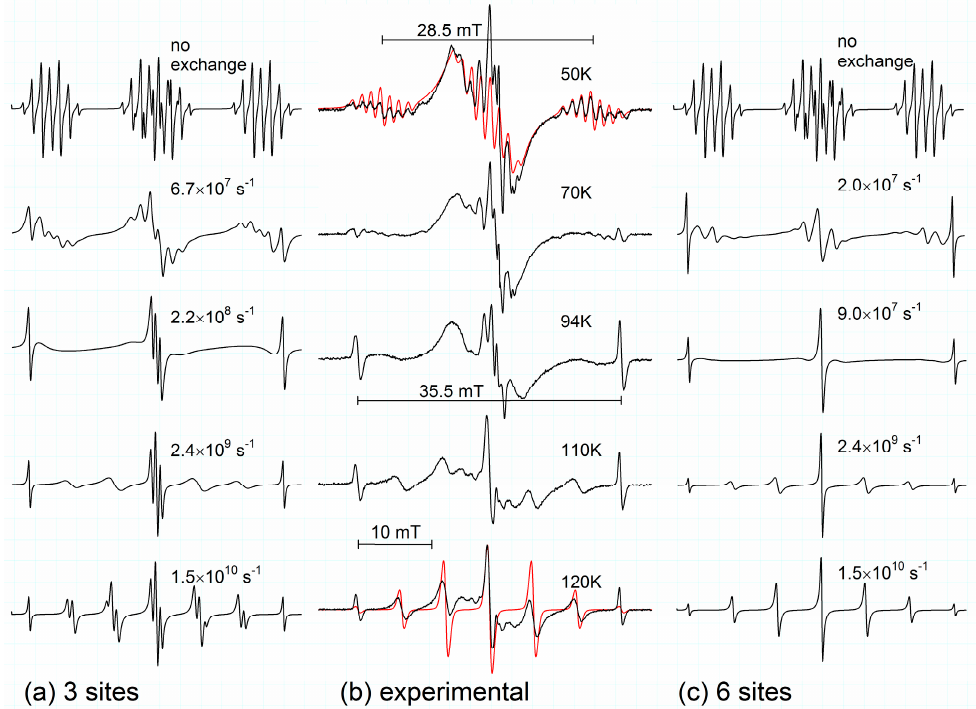
Figure 1. Calculated spectra taking into account the dynamical exchange between three equivalent sites ( a ) and six equivalent sites ( c ). Exchange rates as denoted. EPR-spectra ( b ) measured in irradiated frozen 0.1 mol % s-trioxane/CF 3 CCl 3 solutions in the temperature range 50–120 K. Simulation of rigid half-boat and averaged planar structures shown in red, coupling constants given in Table